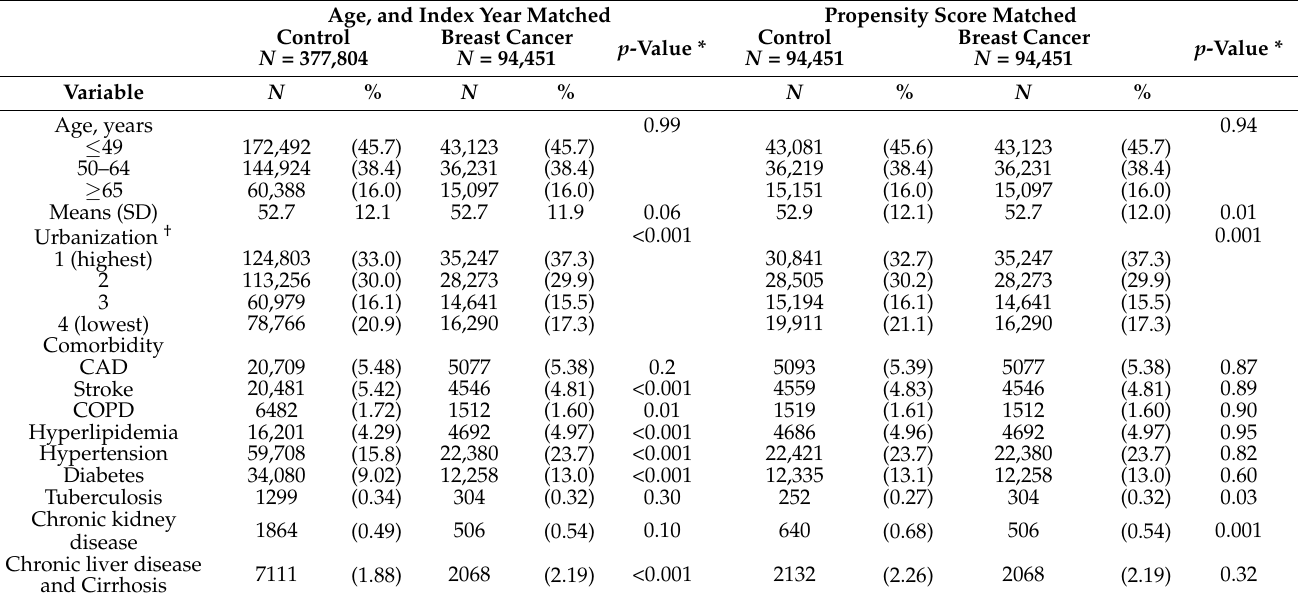
Table 1. Demographic factors and comorbidities of the study participants according to breast cancer